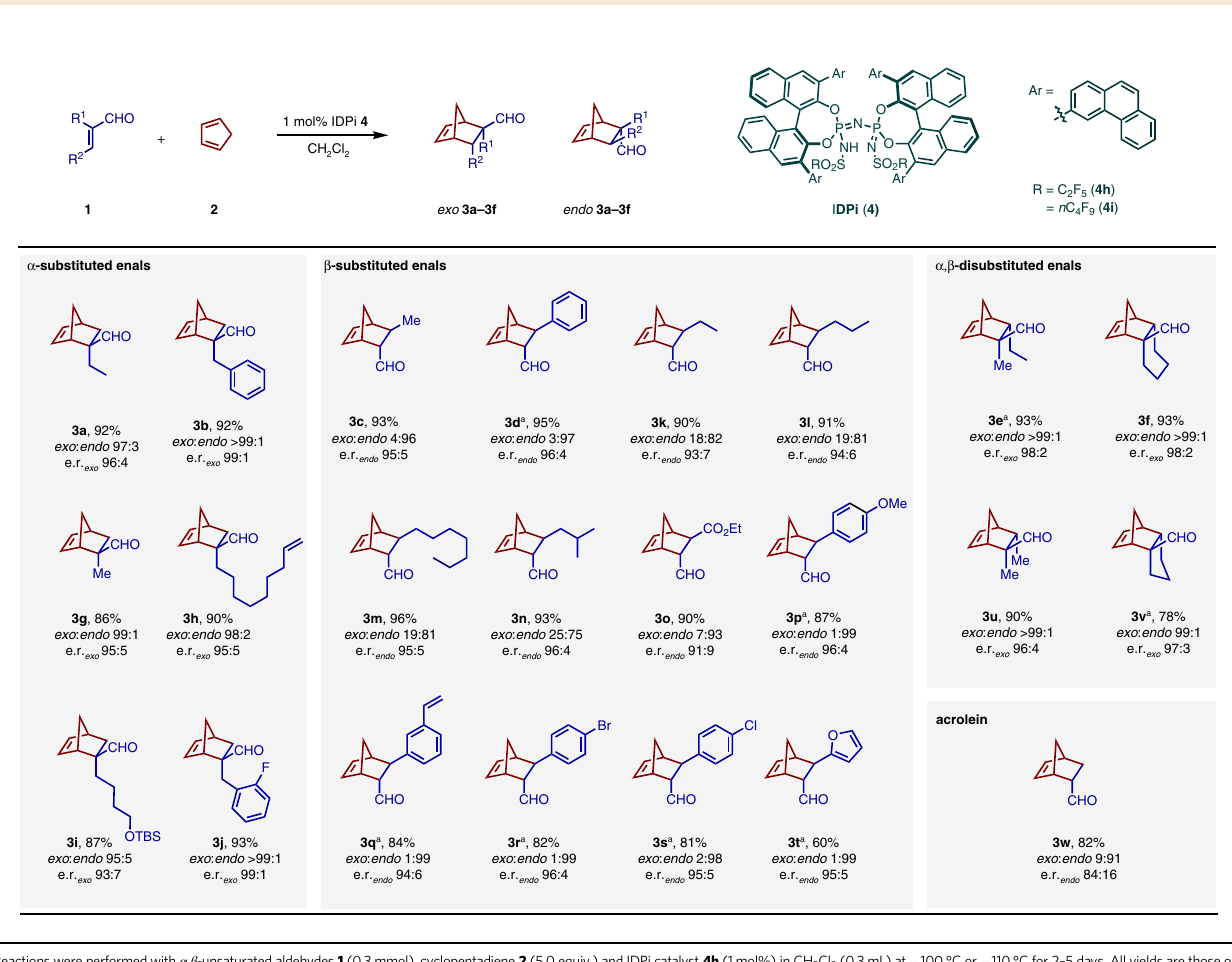
ef fi ciently and stereoselectively ( 3c : 10:90 exo / endo , 73:27 e.r. endo ; 3d – 3f : < 5% conv.). In contrast, catalyst 4e imparted higher enantios- electivities for β -monosubstituted dienophiles 1c and 1d ( 3c : 6:94 exo / endo , 81:19 e.r. endo ; 3d : 2:98 exo / endo , 72:28 e.r. endo ). Notably, the